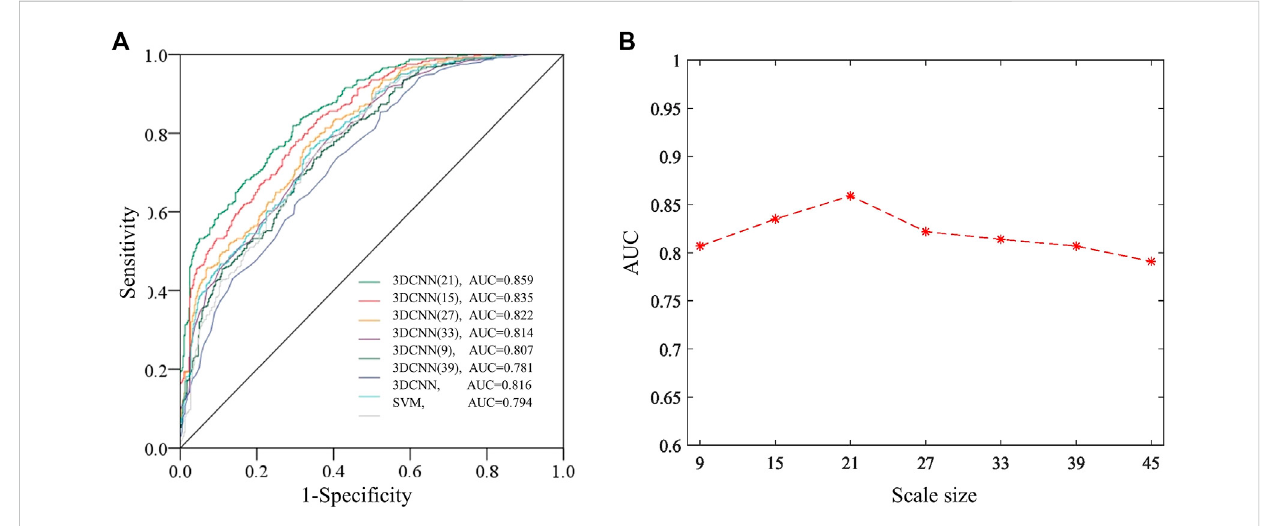
FIGURE 9 The ROC curve. (A) The ROC curve with different scale sizes of input data; (B) The 3DCNN model ’ s AUC and input data ’ s spatial resolution